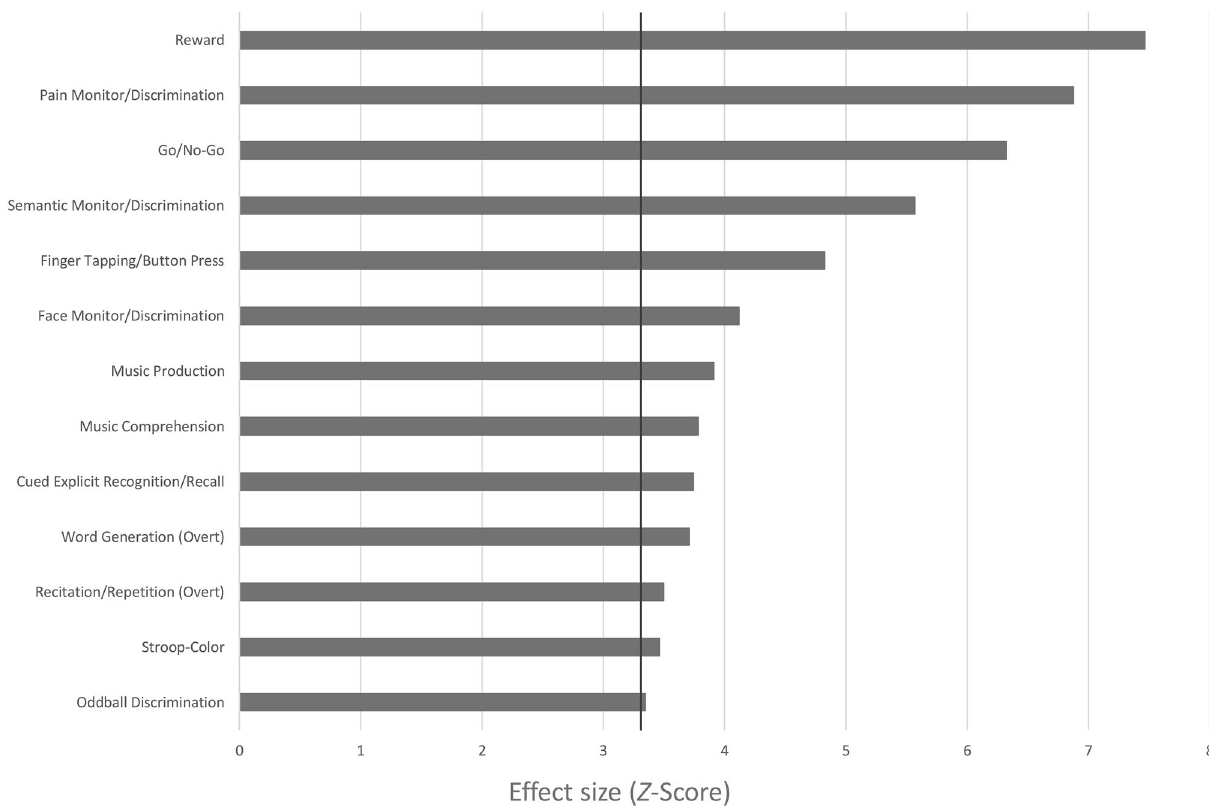
Figure 5. Paradigm Analysis of the ALE derived cluster-network. Only domains with an effect size of Z > 3.3 are shown, as this is significant after correction for the size of the ROI/mask and the number of